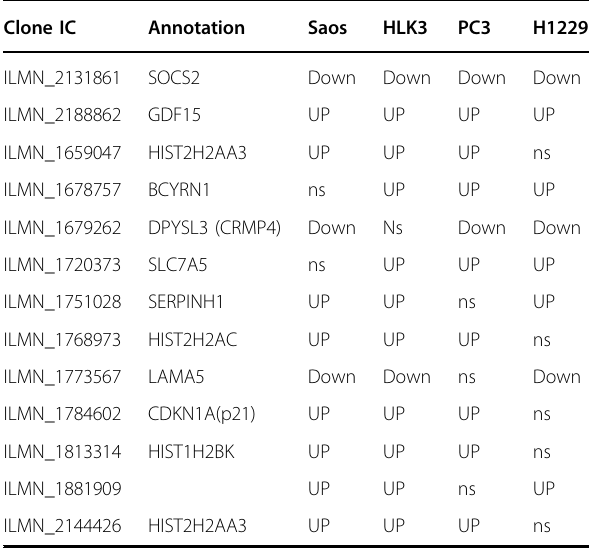
Table 1 Selected genes differentially expressed between p53-expressing and p53-null cells Clone IC